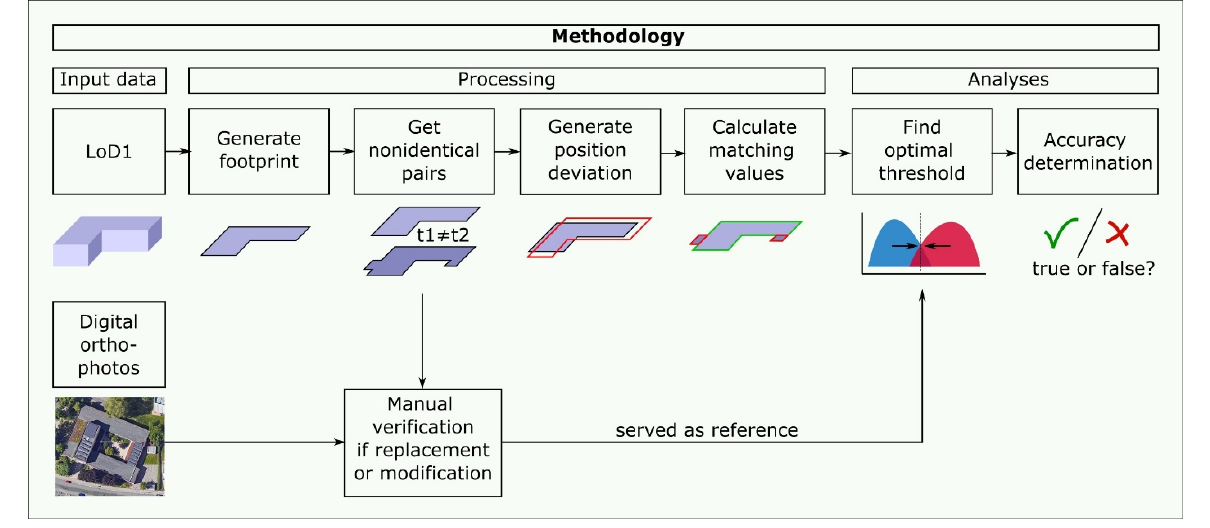
Figure 1. Methodology of this study.